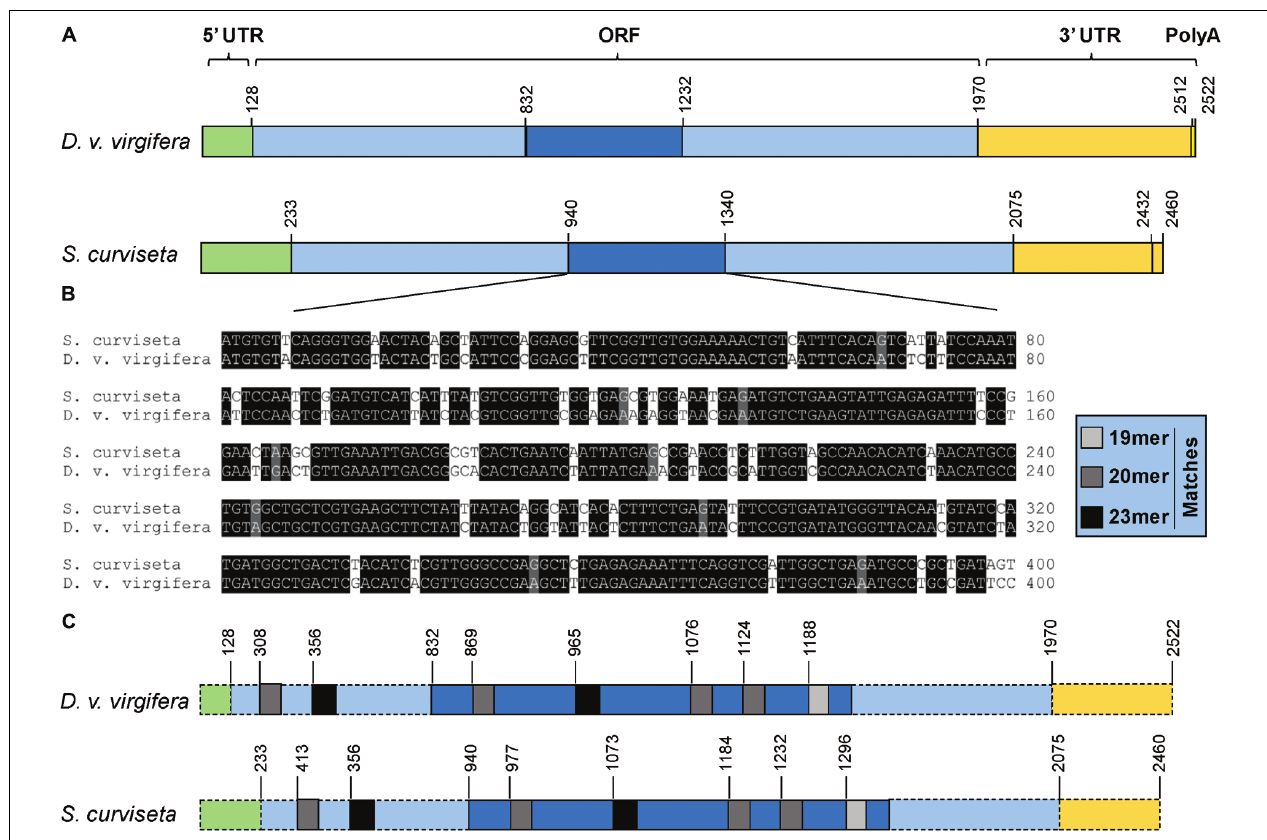
FIGURE 1 | Schematic comparison of v-ATPase A from targeted insect pest, Diabrotica virgifera and non-target Sinella curviseta. (A) Schematic drawing of the primary structures of v-ATPase A cDNA from S. curviseta and D. v. virgifera . (B) The alignment of a highly conserved region within the ORFs of v-ATPase A from S. curviseta and D. v. virgifera . This 400 bp fragment, which has the highest sequence similarity among all the tested surrogate species, was selected as the target template to synthesis insecticidal dsRNAs. (C) This schematic drawing shows the distribution and number of identical sequences,